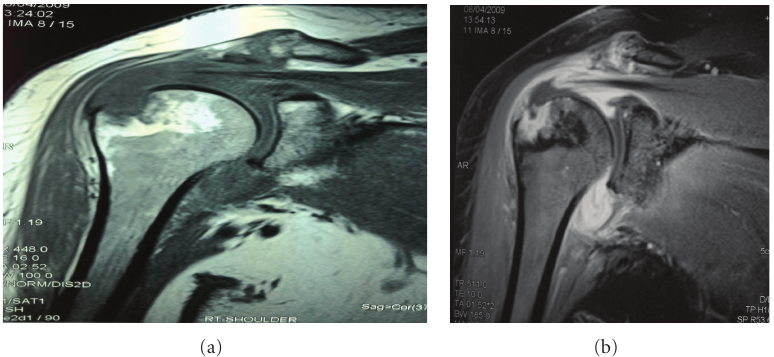
Figure 3: MRI of the right shoulder joint. Coronal T1-weighted (a) and (b) (FS) after IV contrast images of the right shoulder showing dense enhancement of a markedly thickened shoulder joint synovium as well as the subacromial and the subdeltoid bursae with joint e ff usion is noted. A focal 1cm area of erosion and underlying trabecular bone enhancement in the greater tuberosity of the humerus and a full thickness tear of supraspinatus tendon with enhancing edges are evident. There is also associated degeneration of the acromioclavicular joint with hypertrophy of its